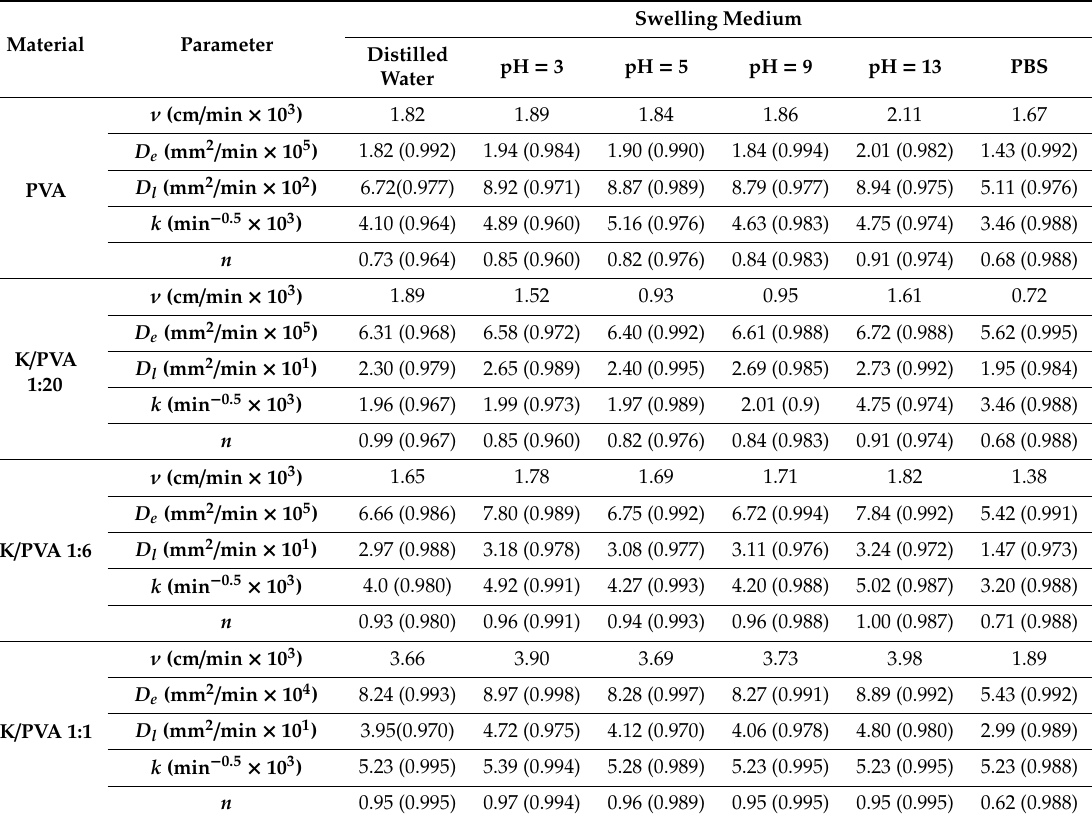
Table 4. Parameters regarding the di ff usion of water into the hydrogel matrix.